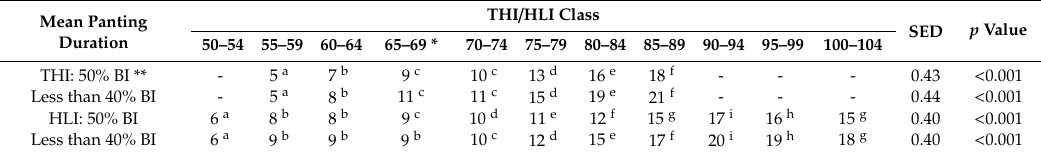
Figure 9. Association between hourly mean thermal index values and mean panting duration (minute) / h of 50% Bos indicus (dark grey circles and trend line) and less than 40% Bos indicus (light grey circles and trend line) cattle. ( A ) Panting duration versus temperature humidity index (THI) (r = 0.90, y = 0.02x 2 − 2.2x + 71.84, R 2 = 0.91 for 50% Bos indicus , and r = 0.92, y = 0.02x 2 − 2.4x + 77.14, R 2 = 0.93 for less than 40% Bos indicus ) and ( B ) Panting duration versus heat load index (HLI) (r = 0.86, y = 0.004x 2 − 0.33x + 12.67, R 2 = 0.77 for 50% Bos indicus , and r = 0.86, y = 0.004x 2 − 0.43x + 17.40, R 2 = 0.80 for less than 40% Bos indicus ). The reference threshold THI and HLI range for heat stress is indicated by shaded zones. The vertical broken lines indicate the point of THI and HLI at which the mean panting duration increased significantly from the base. The error bars in the right hand top corners indicate average SED value for panting duration across THI ( A ) and HLI points ( B ). Table 9. Mean herd level panting duration (minute) for 50% Bos indicus and less than 40% Bos indicus cattle across mean hourly THI and HLI